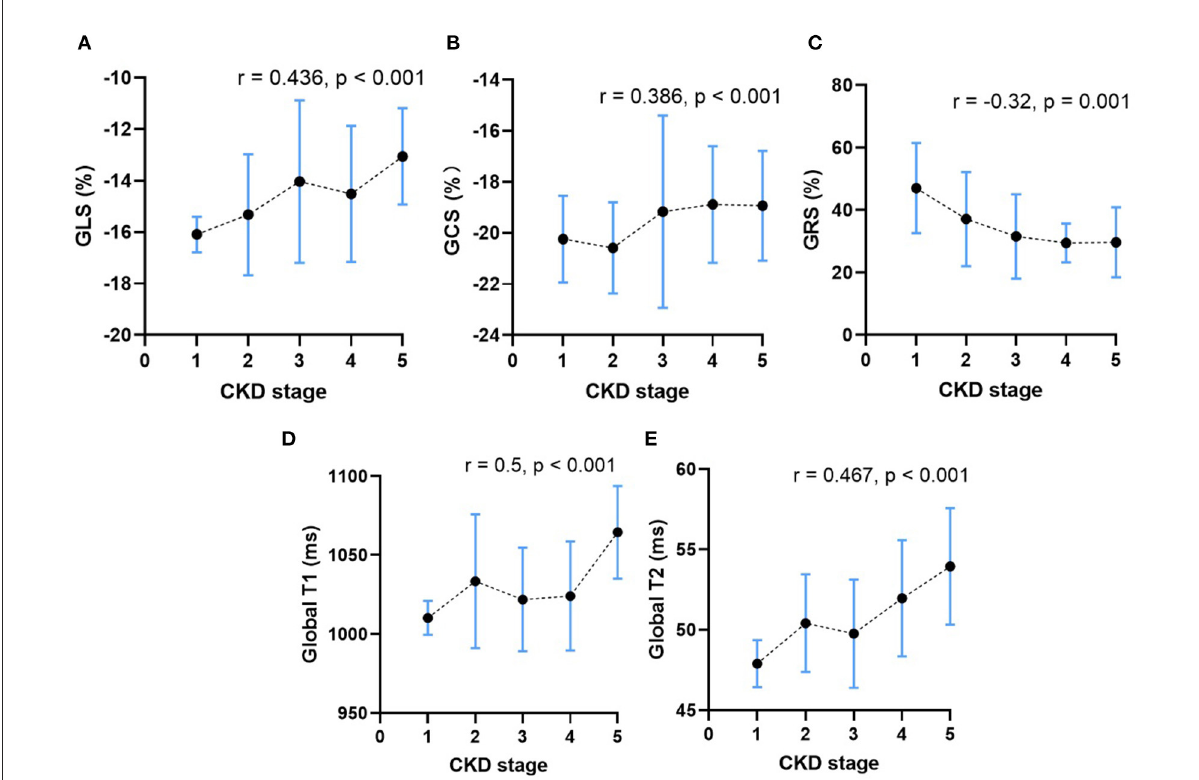
FIGURE5 The relationship between CKD stage and the mean peak global radial strain (A) , peak global circumferential strain (B) , peak global longitudinal strain (C) , the global native T1 values (D) and the global T2 values (E) in CKD patients without HD. The dots represent the mean CMR parameters of patients in each CKD stage, and the vertical bars represent the standard deviation range of CMR parameters of patients in each CKD stage. The dashed line represents the trends of change in CMR